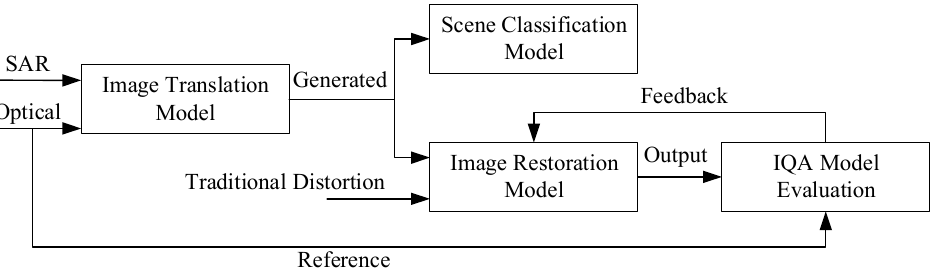
Figure 1. The framework of our algorithm.